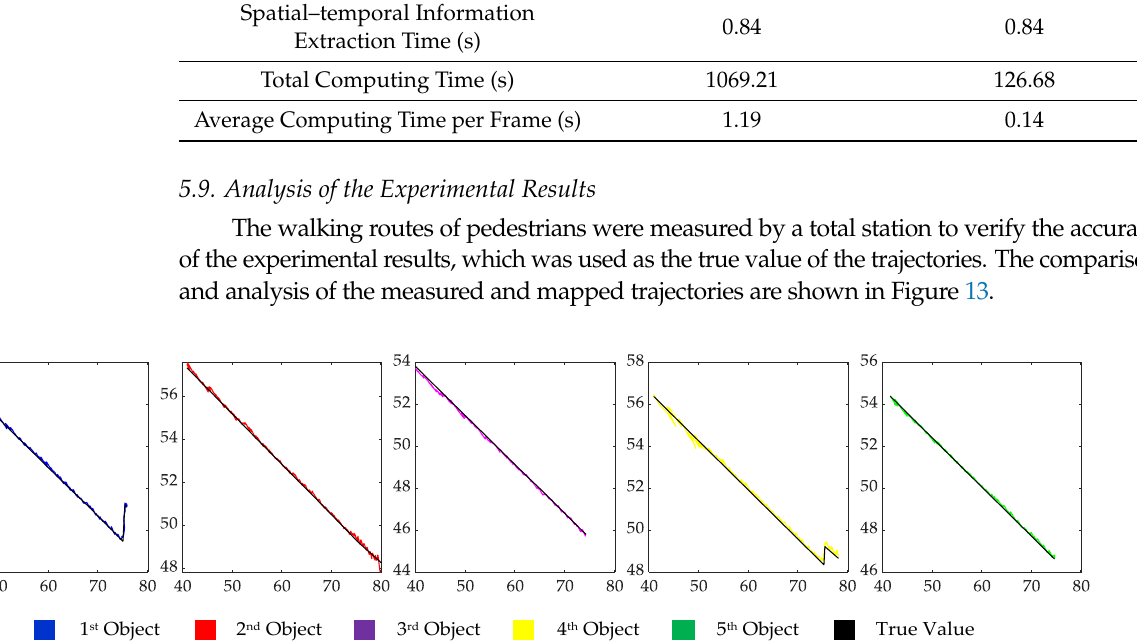
Figure 13. Comparison of the planar position between the measured and mapped trajectories in which the ordinate is X (m), and the abscissa is Y(m).